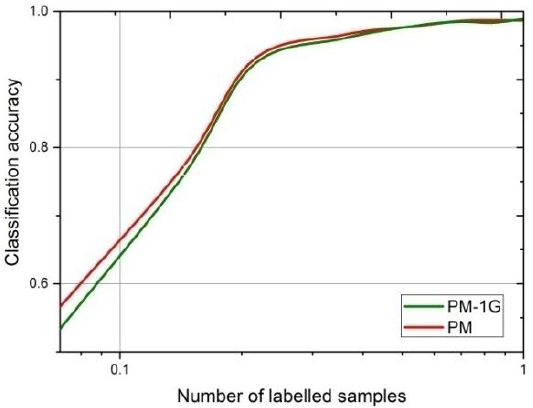
Figure 11. The average recognition accuracy of our network and PM-1G trained using different numbers of labeled images (64×64).